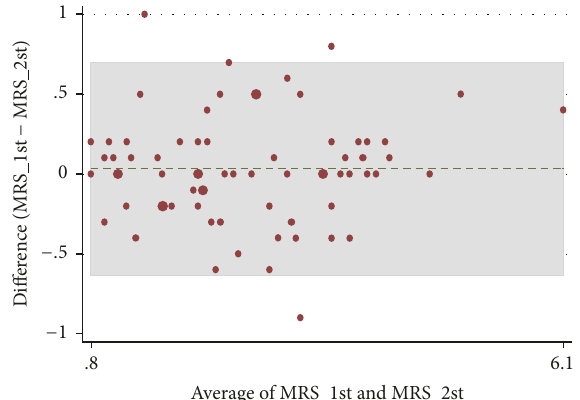
Figure 2: Bland-Altman analysis of combined